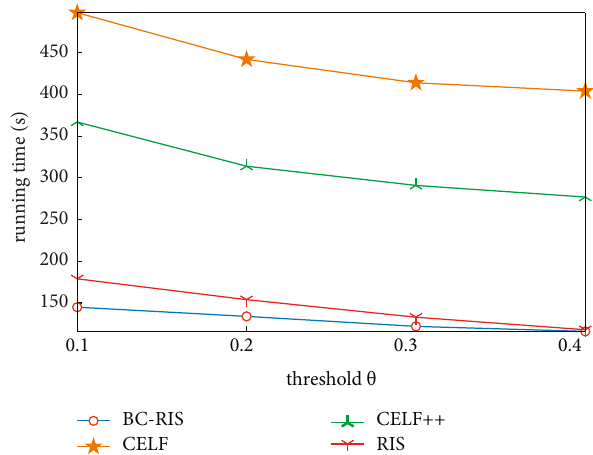
Figure 7: The running time of different influence maximization algorithms, when number of seed nodes is